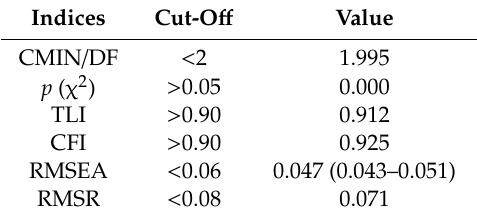
Table 2. BOSS-P goodness-of-fit indices from the confirmatory factor analysis (CFA).